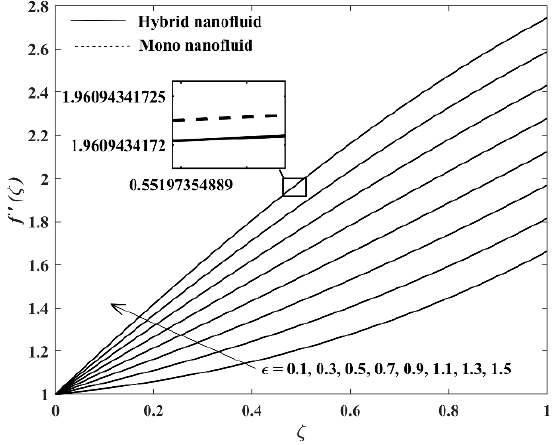
Figure 6. Under the given conditions of We x = 0.05, M = 1.2,Pr = 7, S = − 1.2, and m = 0.8, changes in the unsteadiness parameter ε cause variations in the velocity profiles. These variations can have a significant impact on the velocity distribution and provide valuable insights into the behavior of the system. Table 11. As the unsteadiness parameter ε undergoes variation, numerical approximations are made for the local Nusselt number, θ (cid:48) ( 0 ) based on specific parameters, including We x = 0.05, M = 1.2, Pr = 7, S = − 1.2, and m = 0.8. θ ’ (0) ε φ 1 = 0.01, φ 2 = 0.02